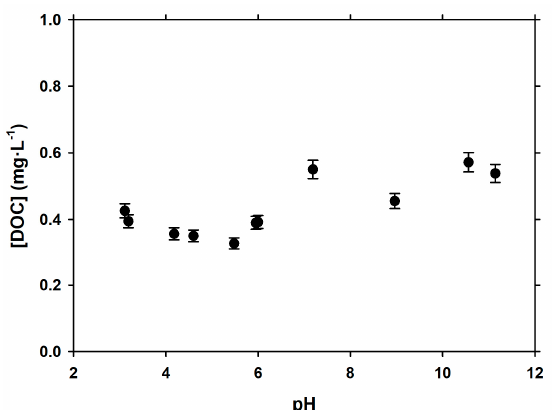
Figure 4. DOC concentration in experiments with 0.2 and 0.5 g wet /L of EOMI diatoms after 60 min of exposure to 60 µg/L of AuNPs during 60 min. The error bars (s.d. of duplicates) are within the symbol size unless shown.